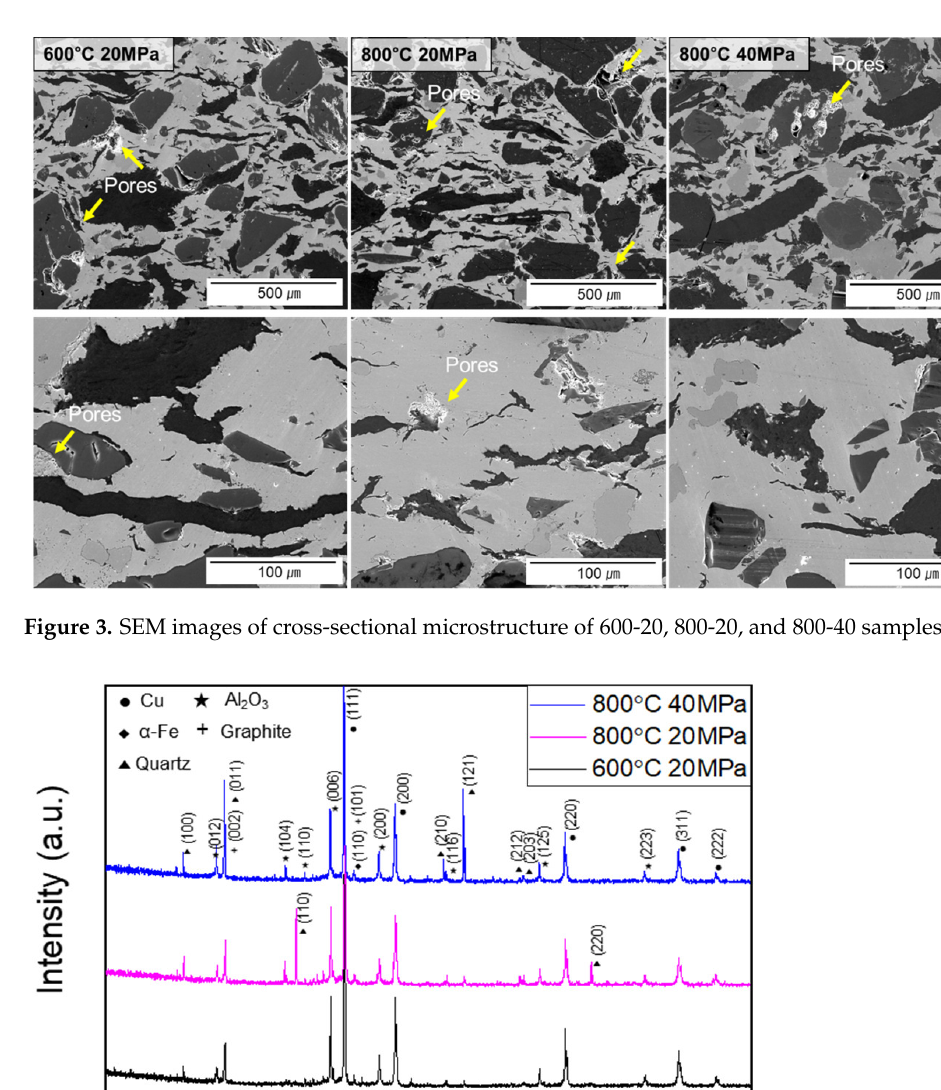
Crystals 2021 , 11 , x FOR PEER REVIEW 6 of 15 nanometers in size, its SADP pattern contained a denser ring pattern compared with that for the bottom region (grain size of hundreds of nanometers), further confirming the for- mation of a gradual grain size distribution during the SPS process.